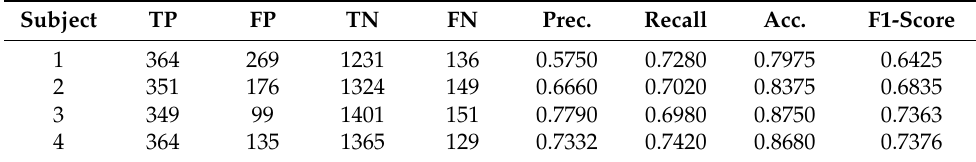
Table 5. Performance on test dataset from Dataset 1.